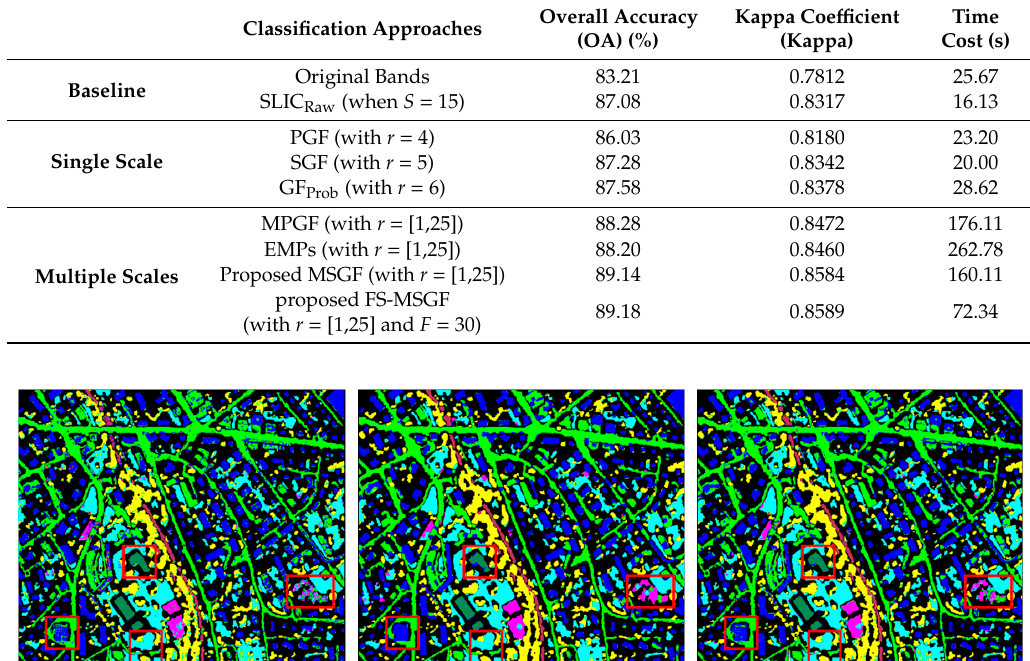
Table 3. Classification results of Zh2 obtained by the proposed and reference methods.